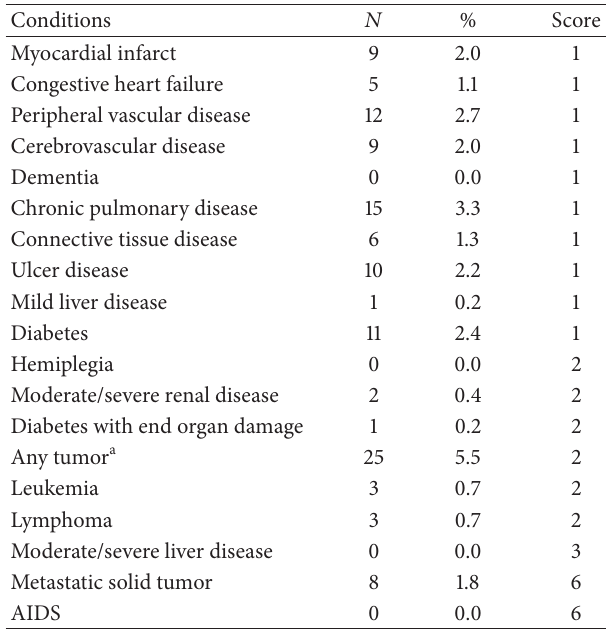
Table 1: Prevalence and scores of medical conditions as listed in the Charlson Comorbidity Index among adult bone sarcoma patients treated at the Aarhus Sarcoma Centre between 1979 and 2008 (𝑁 = 453)